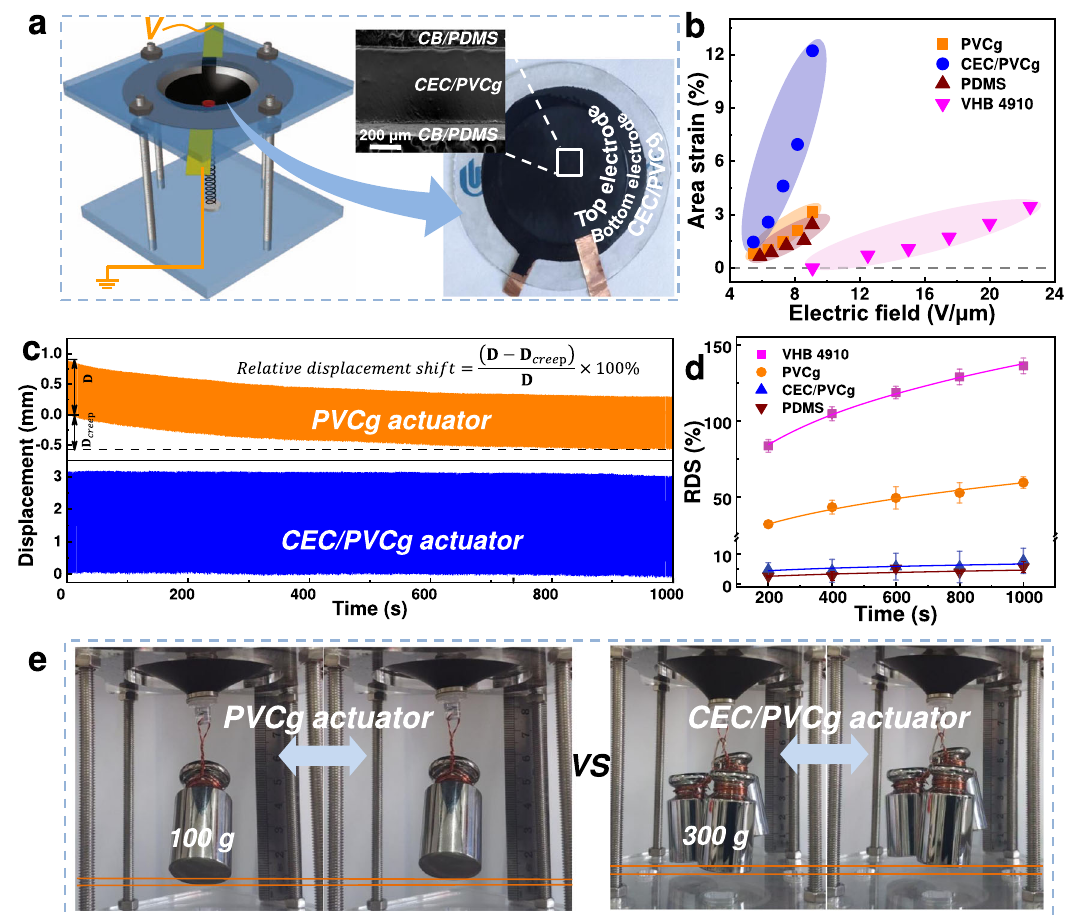
Fig. 5 | Actuation test. a Photograph and cross-sectional SEM image (right) of the prepared DEA device, where a CEC/PVCg fi lm (transparent, ~470 μ m thick) was sandwiched between two CB/PDMS electrodes (black, ~15 μ m thick). The sand- wiched structure was fi xed by a circle frame ( ϕ =50mm) and took out-of-plane actuation as assistedby anelastic spring (leftschematic). The sheet resistanceand bulk conductivity of the electrode were ~1140 Ω /sq and ~42mS/cm, respectively. b The produced area strains by the PVCg, CEC/PVCg, PDMS, and VHB 4910 actuators under various driving electric fi elds. c The displacement pro fi les of the